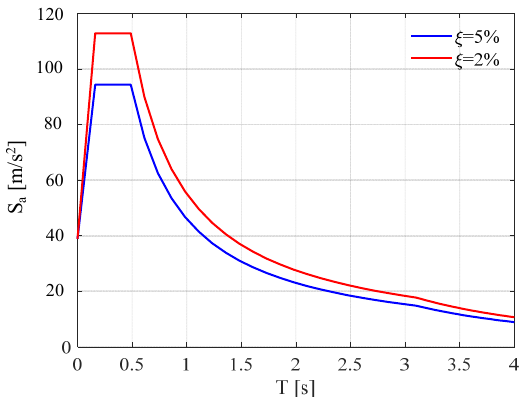
Figure 7. Elastic design response spectra according to nearly ‐ collapse limit state [2] with two different damping ratios.